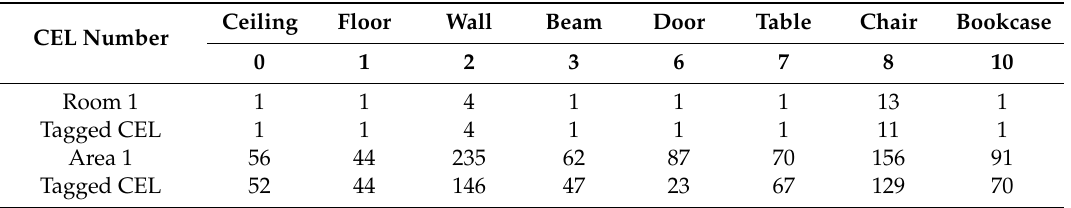
Table 7. Quantitative CEL segmentation compared to nominal number of elements per class for both a room (Conference room) and area (area 1).